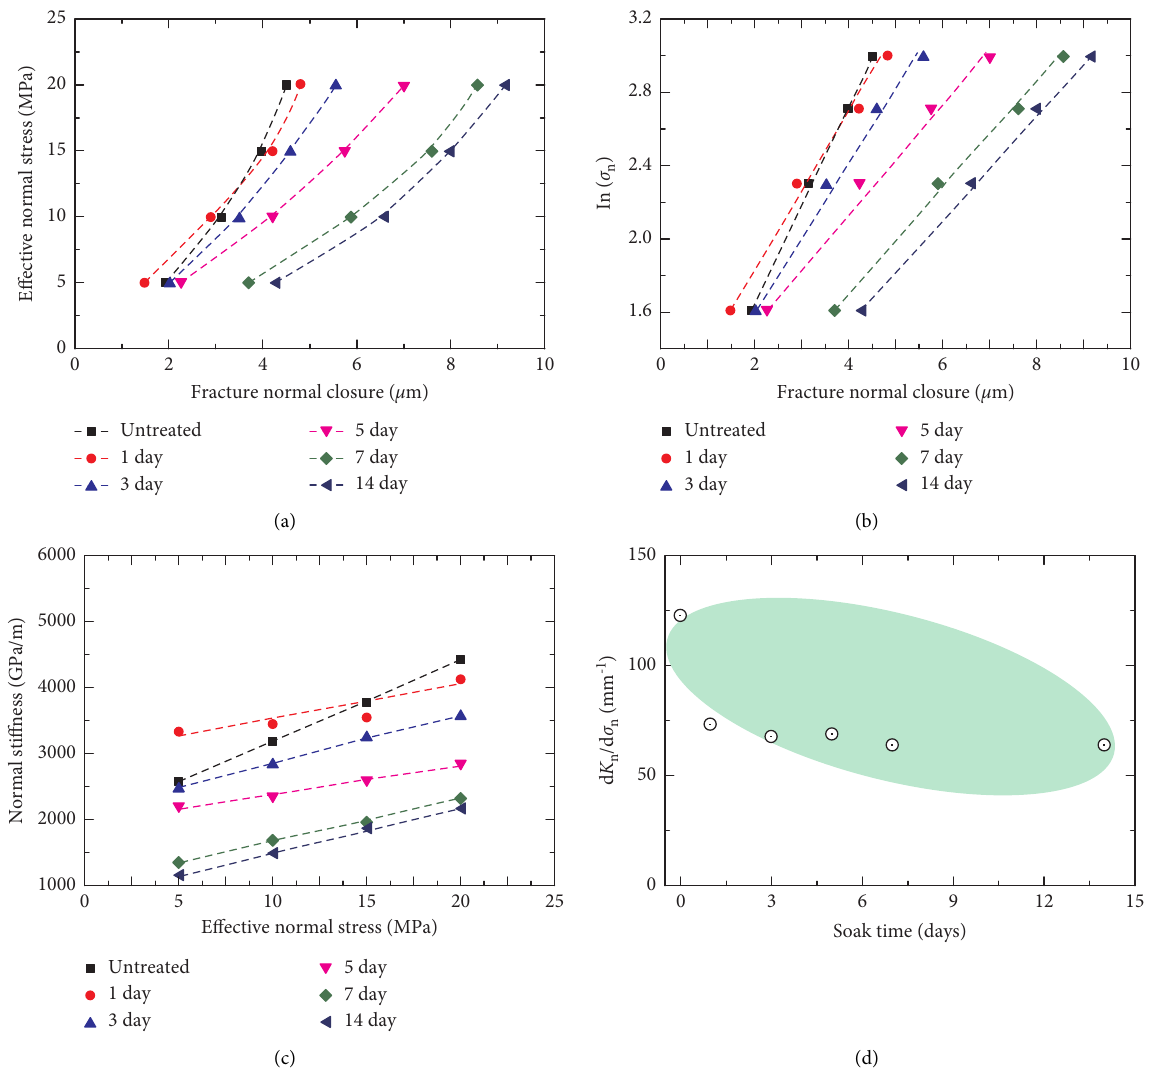
Figure 3: The logarithmic closure law describes the fracture closure. (a) The relationship between fracture normal closure and effective normal stress; (b) a linear relationship is observed for fracture normal closure and logarithmic normal stress; (c) the linear relationship between effective normal stress and fracture normal stiffness; (d) a decrease of stiffness characteristic value with soaking